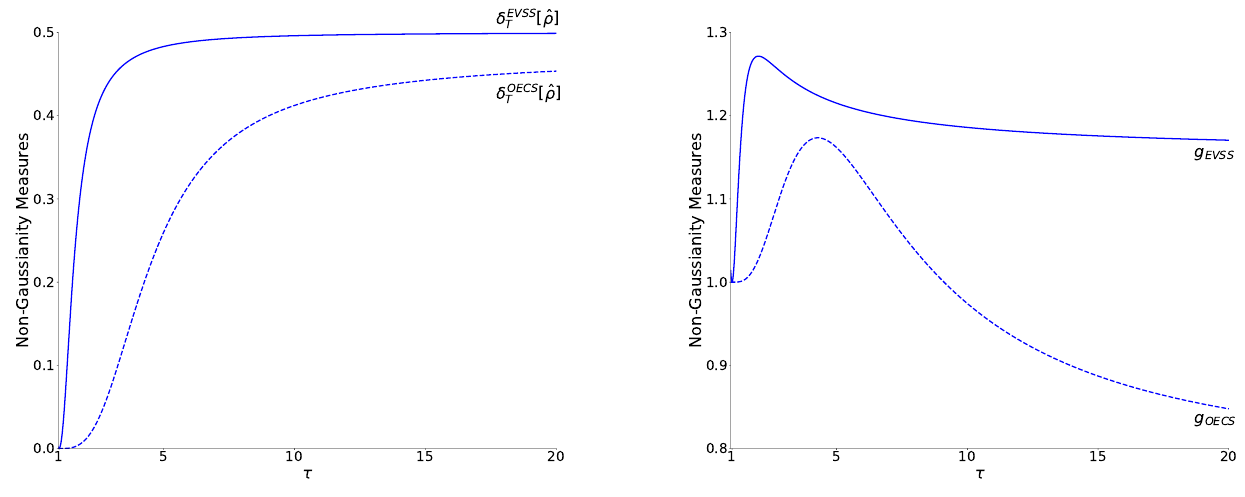
Figure 9. Non-Gaussianity measures as functions of the inverse fidelity τ between the vacuum state and components of two kinds of superpositions. ( Left ) The measures δ T [ ˆ ρ ]( τ ) for EVSS and OECS; ( Right ) The measures g ( τ ) for EVSS and